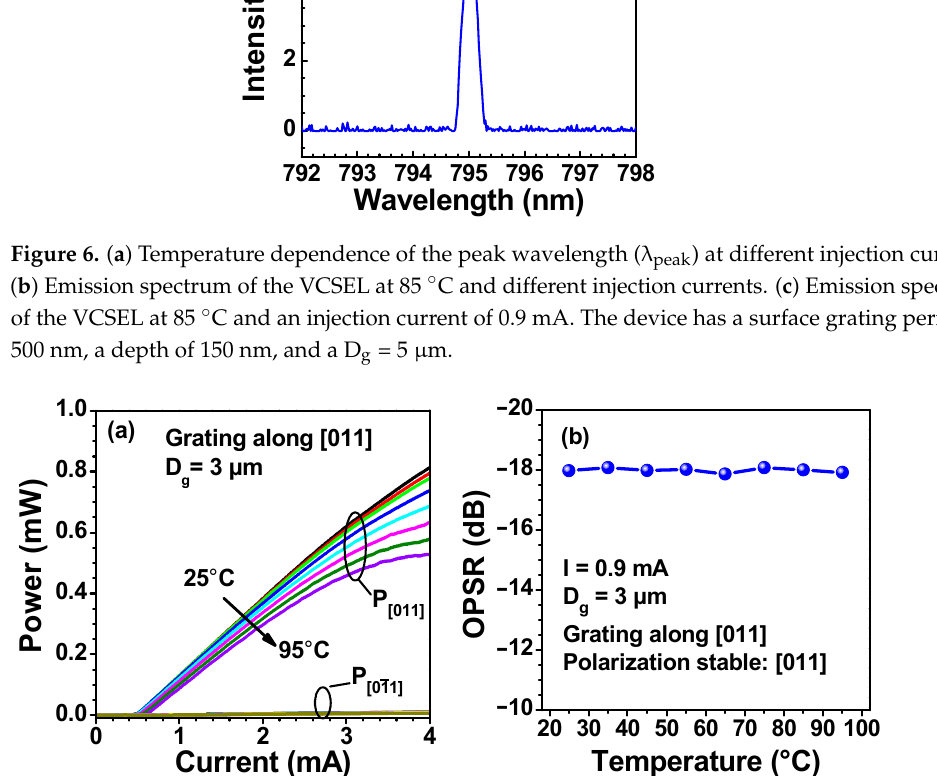
Figure 6. ( a ) Temperature dependence of the peak wavelength ( λ peak ) at different injection currents. ( b ) Emission spectrum of the VCSEL at 85 °C and different injection currents. ( c ) Emission spectrum of the VCSEL at 85 °C and an injection current of 0.9 mA. The device has a surface grating period of 500 nm, a depth of 150 nm, and a D g = 5 μ m.